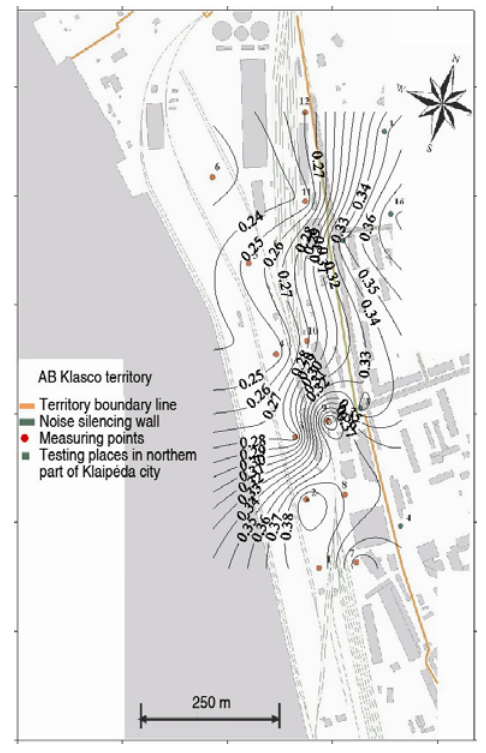
Fig 6 . Dustiness in the evening in September